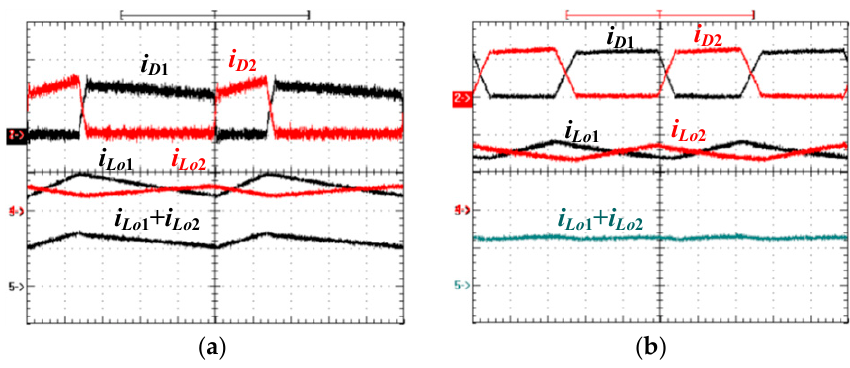
Figure 10. Test results of the primary capacitor voltages under ( a ) 20% load [ V Cb 1 ~ V Cb 3 : 100 V/div; time: